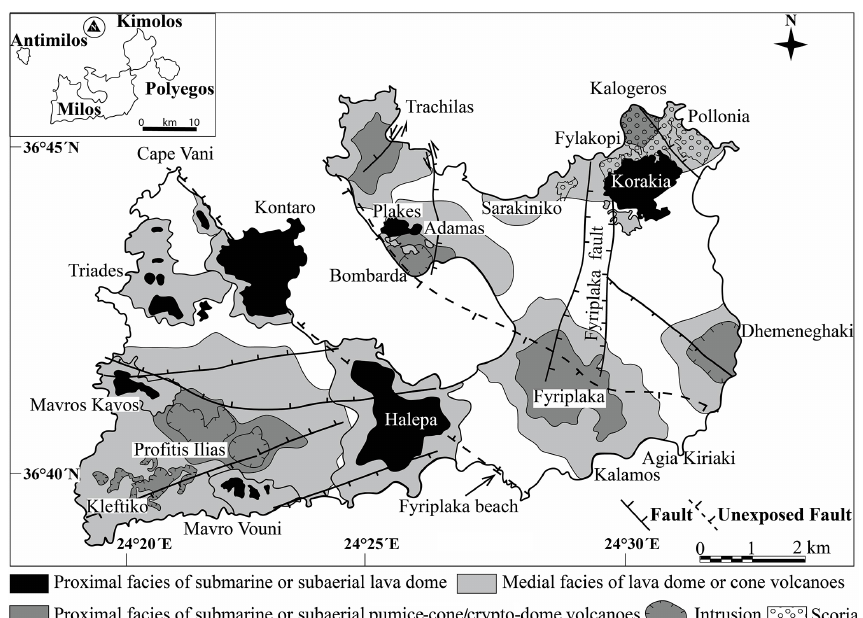
Figure 2. Distribution of the proximal and medial facies of the submarine pumice-cone/crypto-dome volcanoes, submarine, submarine– subaerial and subaerial domes, and rhyolitic complexes (tuff cone and associated lava) of Milos, modified after Fytikas et al. (1986) and Stewart and McPhie (2006). The distal facies of Stewart and McPhie (2006) is not